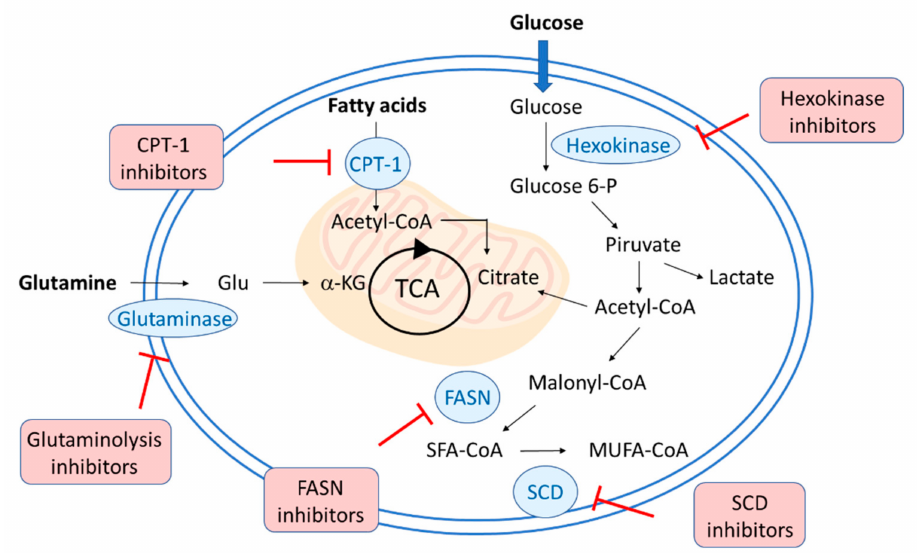
Figure 1. Schematic representation of the metabolic strategies to target viral replication. Hexokinase inhibitors interfere with glycolysis and glucose metabolism, whereas glutaminolysis inhibitors block the glutamate formation from glutamine. The lipid metabolism can be affected with different strategies: carnitine palmitoyl transferase 1 (CPT1) inhibitors block the entry of long-chain fatty acids into mitochondria for oxidation, fatty acid synthase (FASN or FAS) and stearoyl-CoA desaturase (SCD) inhibitors strongly interfere with lipogenesis.